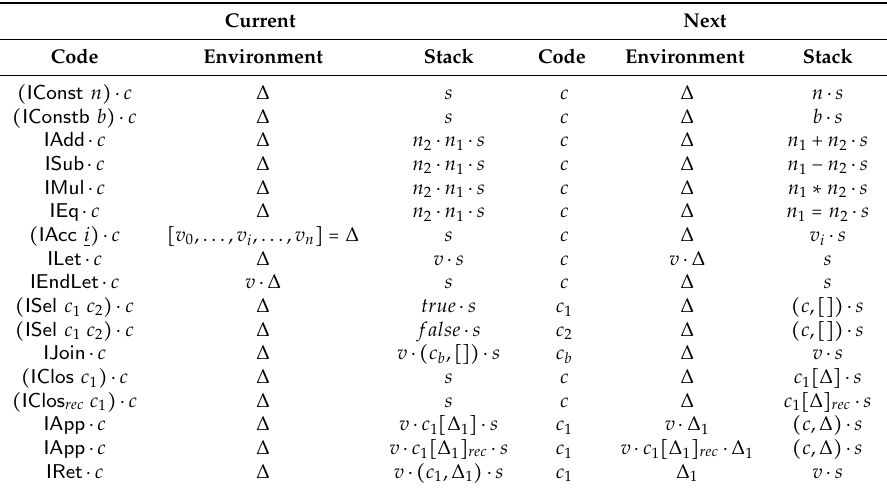
Table 1. MSECD small-step